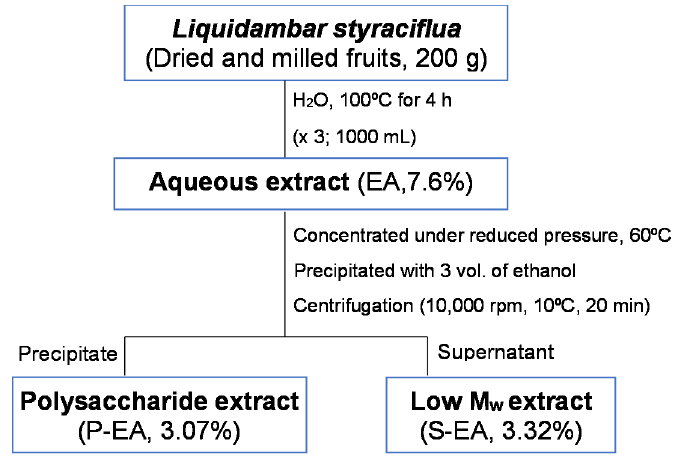
Figure 9. Schematic representation of the L. styraciflua fruits